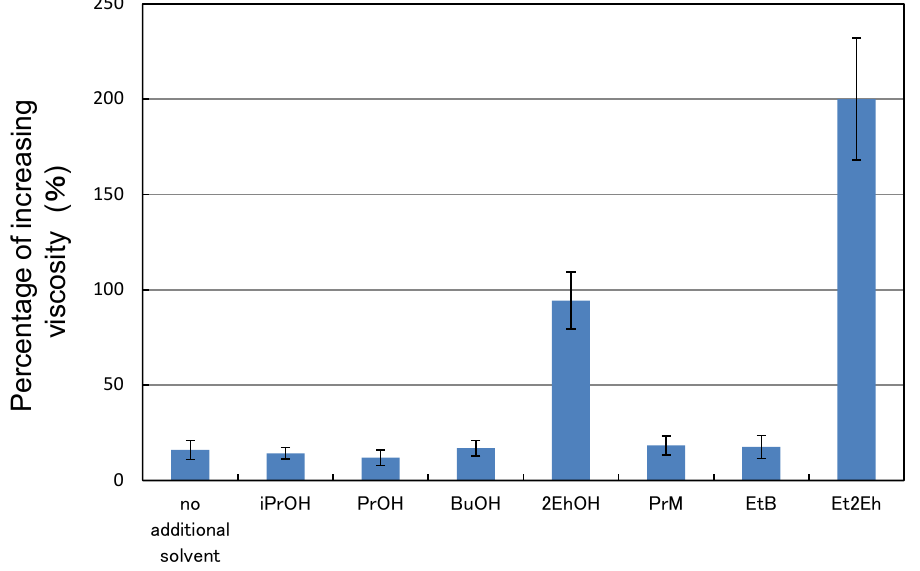
Figure 10. Increasing viscosity percentage levels for paint samples with different solvent compositions. Figure 11 shows the relationship between the water solubility of the organic solvent and the increasing viscosity percentage levels. Solvents with water solubility levels exceeding 10 g/100 mL are plotted as 20 g/100 mL. As shown in Figure 10, no correlation can be found between the water solubility and the percentage of increasing viscosity. Figure 12 shows the relationship between the boiling point of the organic solvent and the increasing viscosity percentage levels. Figure 12 shows that the increasing viscosity percentage levels increase with the increasing boiling point, which indicates that the storage stability tends to deteriorate.